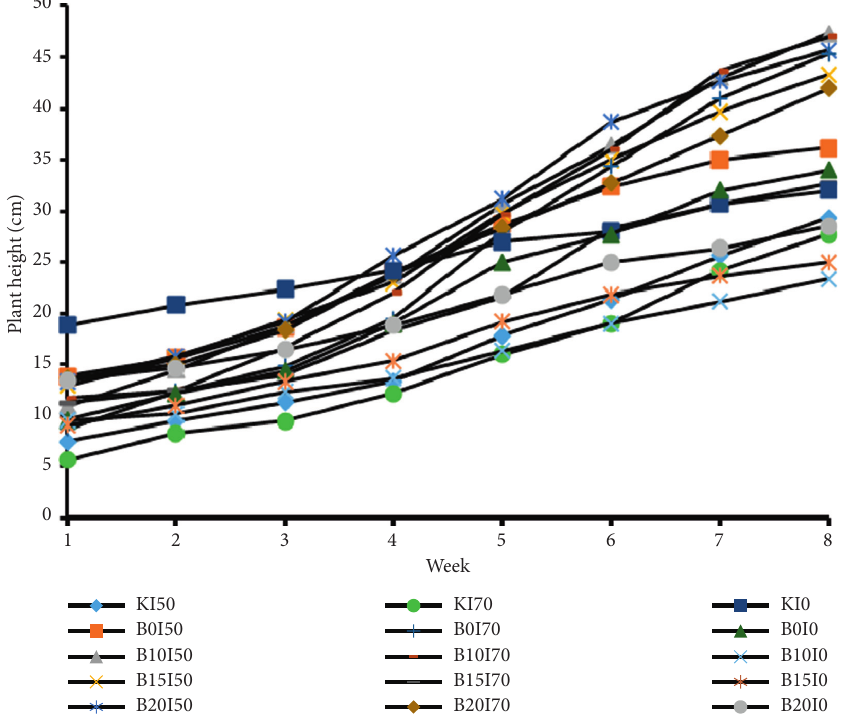
Figure 1: Plant height of longevity spinach as affected by biochar and shade